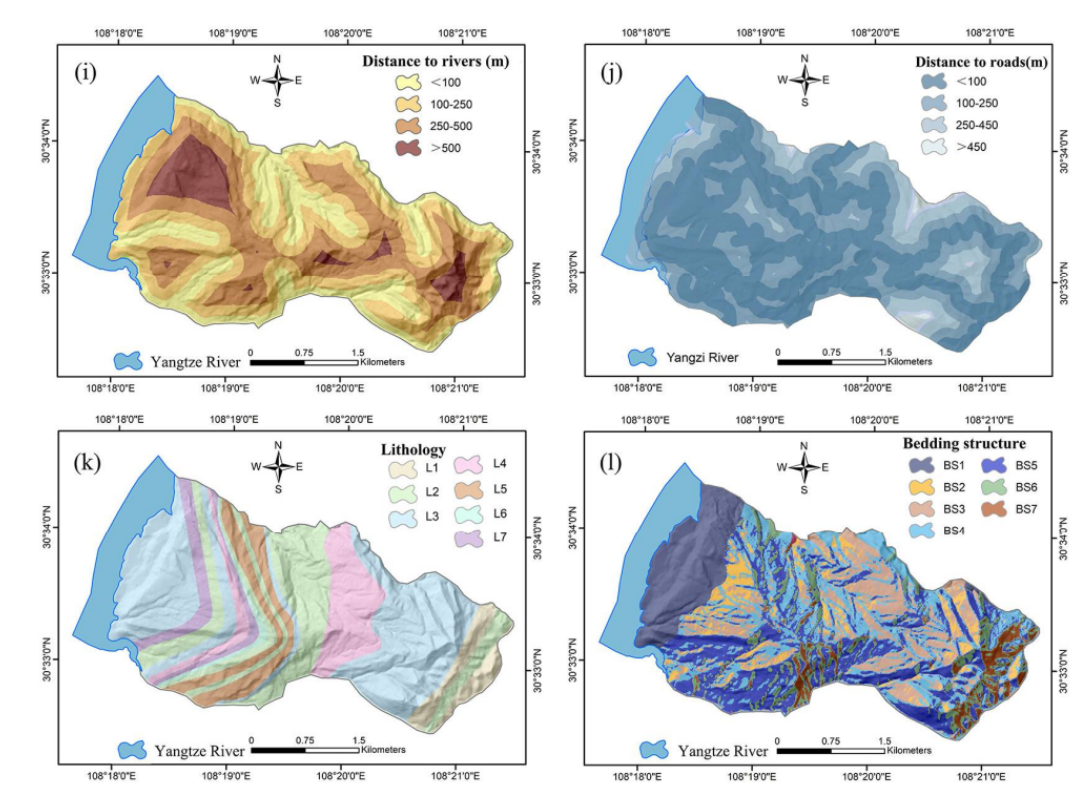
Figure 4. Thematic maps of landslide causal factors: ( a ) altitude, ( b ) slope, ( c ) aspect, ( d ) curvature, ( e ) plan curvature, ( f ) profile curvature, ( g ) TRI, ( h ) TWI, ( i ) distance to rivers, ( j ) distance to roads, ( k ) lithology, ( l ) bedding